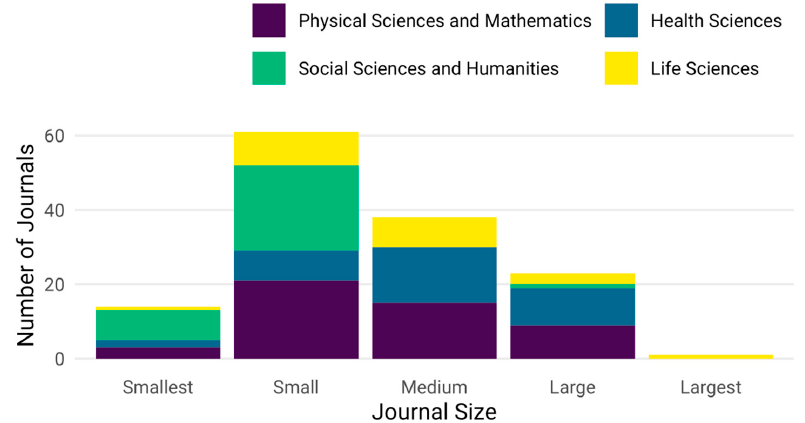
Figure 6. The number of reverse-flip journals categorized by journal size and discipline (categories for average annual article volume: Largest ≥ 600, Large 150–599, Medium 60–149, Small 20–59, Smallest 1–19).